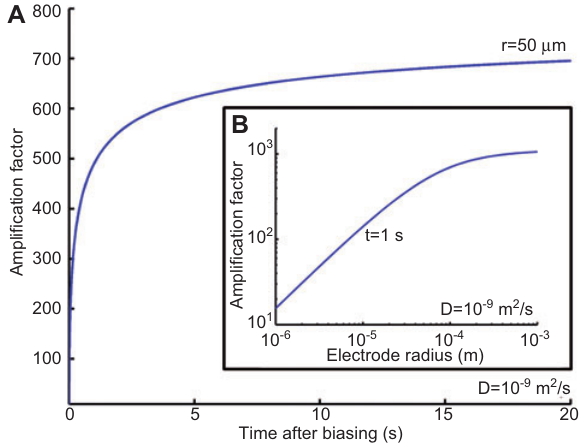
Figure 2 Amplifi cation by the redox cycling effect. The presented plots picture the analytically determined amplifi cation factors of the Faradaic currents obtained from a redox cycling sensor compared to a single disk electrode of equal size. (A) Presents the amplifi cation as a function of the time passed since the electrode was biased for an electrode radius of 50 μ m. (B) Shows the amplifi cation at t = 1 s as a function of the electrode